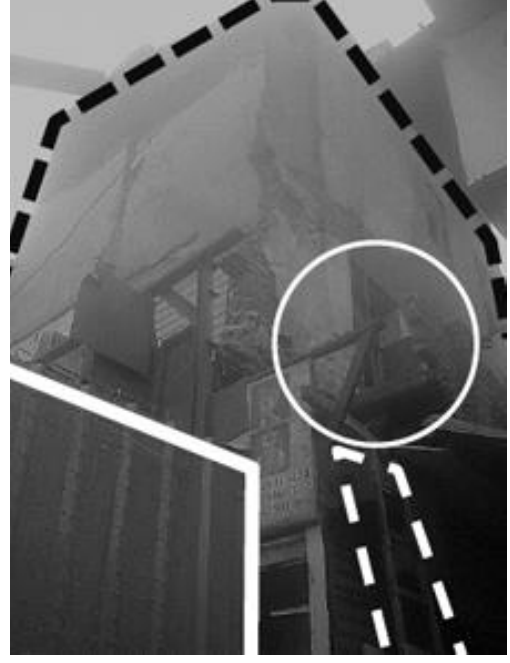
Figure 19 One of the attached